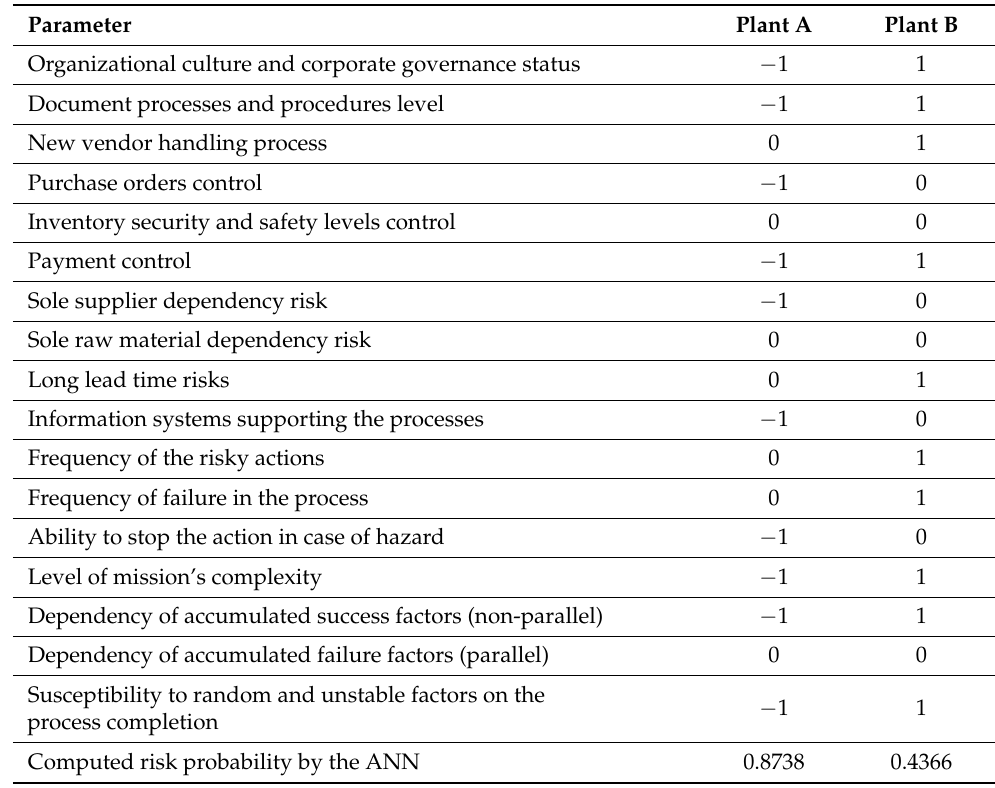
Table 4. Parameters of two plants for validating the